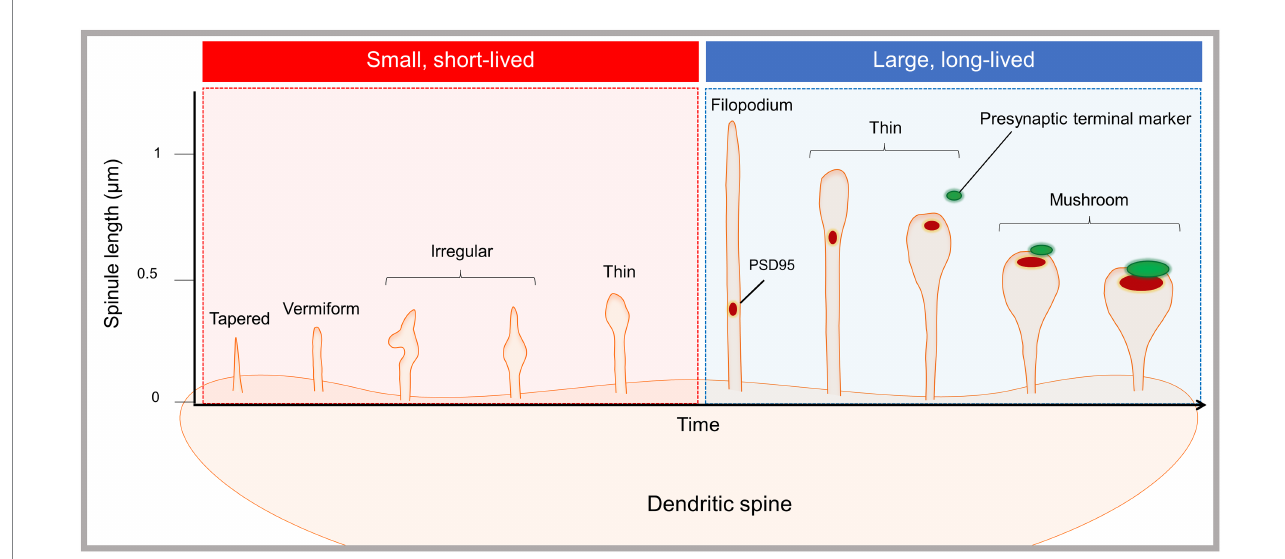
FIGURE 1 Emergence of morphologically and functionally distinct spinule subsets. The proposed spinule classification system is based on our recent live-cell, time- lapse, enhanced resolution imaging study of spinules in cortical mouse neurons (Zaccard et al., 2020). The majority of spinules emerging from mushroom spines were dynamic and short-lived, existing for sec and up to 1 min, while a minority of spinules were larger and long-lived. Short-lived spinules were typically less than 0.5 microns in length, and displayed diverse morphologies, e.g., tapered, vermiform, irregular, and thin shapes. Long-lived spinules existed for ≥ 60 s, in some cases exceeding imaging durations up to 10 min, and were typically between 0.5 and 1 microns in length. Additionally, a subset of filopodia-shaped spinules extended up to several microns. Both filopodia and thin spinules often trafficked PSD fragments or contacted presynaptic terminals, but not both. Mushroom spinules were the most stable, with colocalized presynaptic and postsynaptic markers at enlarged spinule tips. Synaptic activity enhanced the number of spinules and the proportion of elongated, long-lived